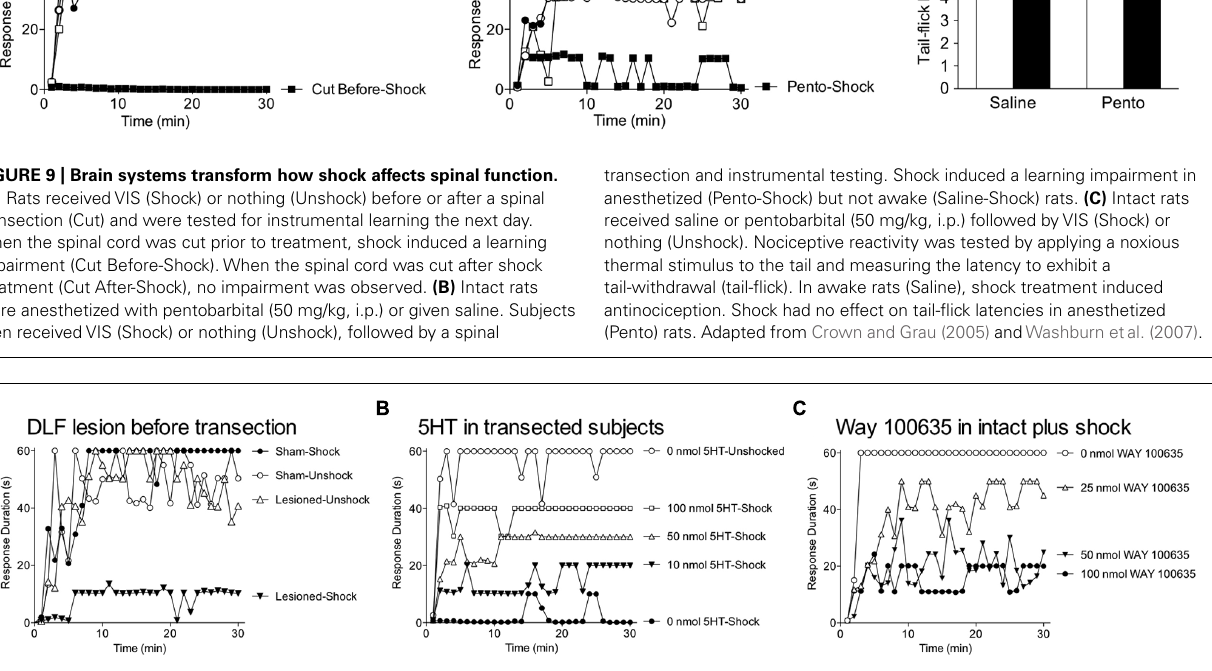
FIGURE 10 | Descending serotonergic systems modulate the induction of the shock-induced learning impairment. (A) Subjects underwent bilateral lesions of the DLF at T2 or a sham surgery. Two hours later the spinal cord was transected at T8 and instrumental learning was assessed the next day. Shock treatment induced a learning impairment in DLF lesioned rats (Lesioned-Shock) but not in intact sham operated rats (Sham-Shock). (B) Spinally transected rats received serotonin (i.t.; 0, 10, 50, or 100 nmol) followed by VIS (Shock) or nothing (Unshock). Instrumental learning was tested the next day. Shock treatment impaired learning in